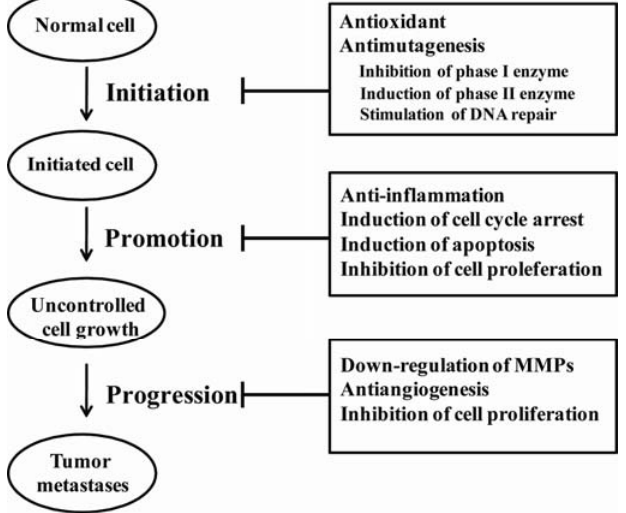
Figure 4. Potential anticancer mechanisms of plant phenolics during cancer